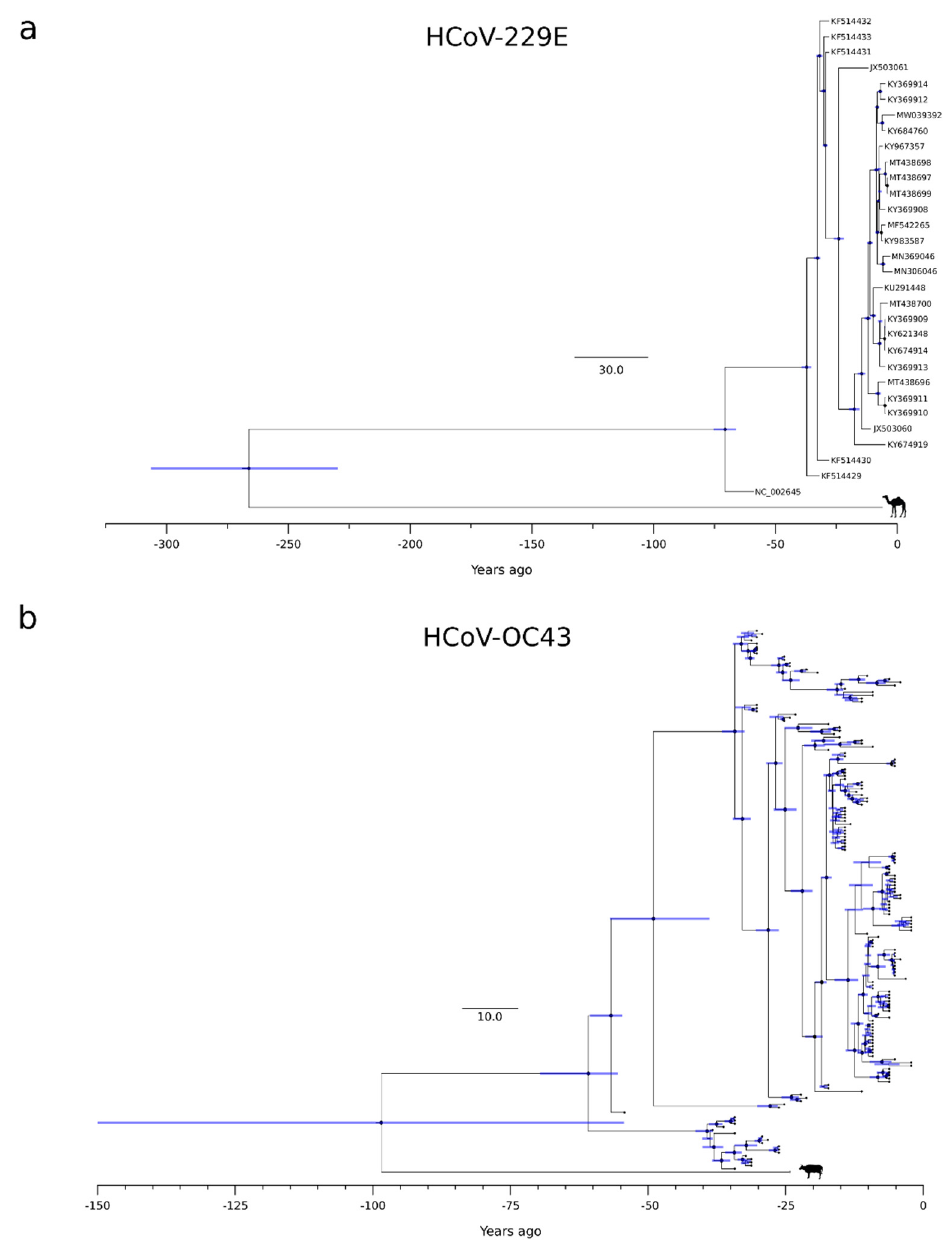
Figure 2. HCoV-229E and HCoV-OC43 timescaled phylogenetic trees. Maximum likelihood trees estimated for the non-recombinant region of HCoV-229E ( a ) and HCoV-OC43 ( b ). Branch lengths represent the evolutionary time measured by the grids corresponding to the timescale shown at the tree base (in years). For internal nodes, 95% HPD bars are shown, and black dots indicate a posterior probability > 0.80 for that node.